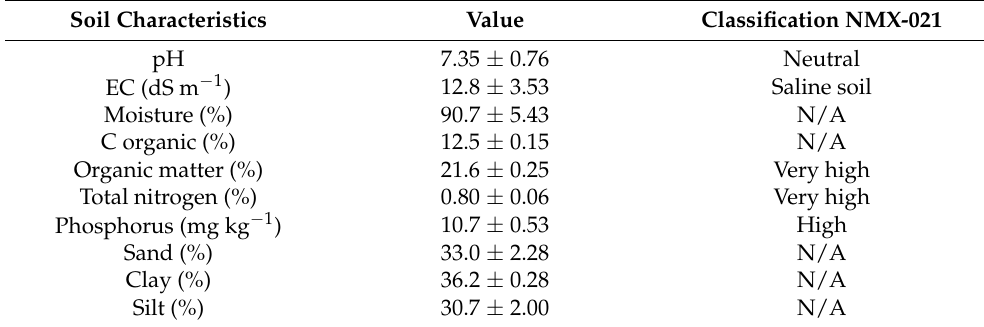
Table 1. Physicochemical characterisation of the soil collected in the Chinampas area of Xochimilco, Mexico City, according to the Mexican NMX-021 norm. Mean values ± SD ( n = 5) are shown for each soil